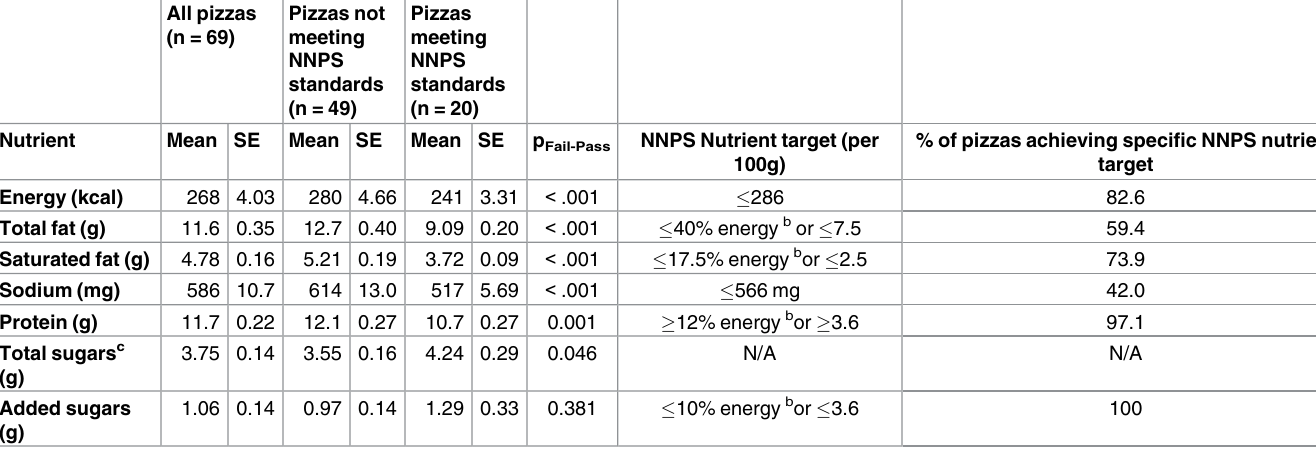
Table 3. Mean nutrient content per 100 g of pizza food codes in the FNDDS 2011–12database, by NNPS standards a . All pizzas (n =